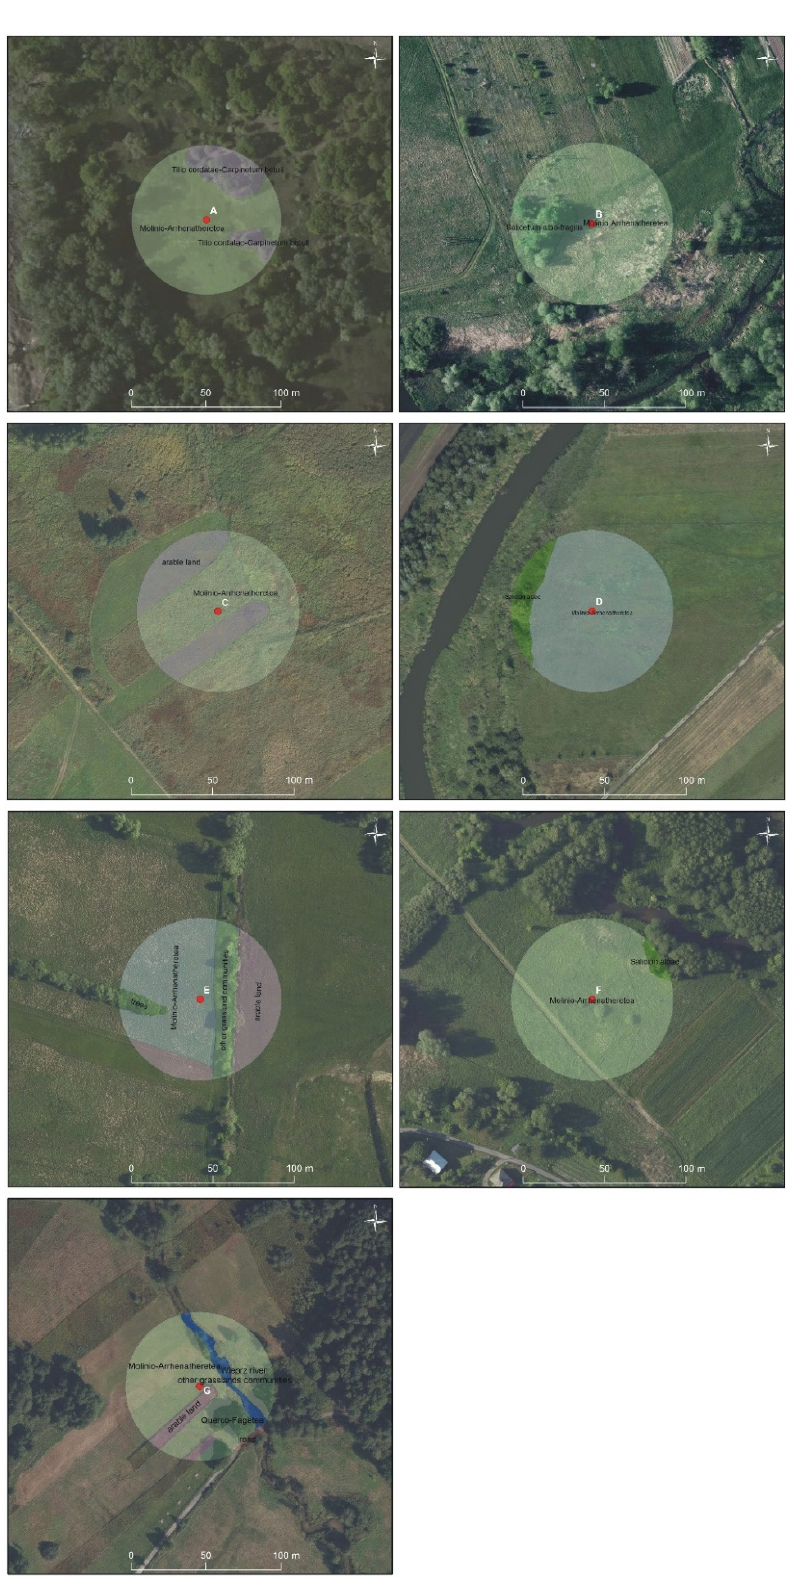
Figure A1. Structure of plant communities in research plots.